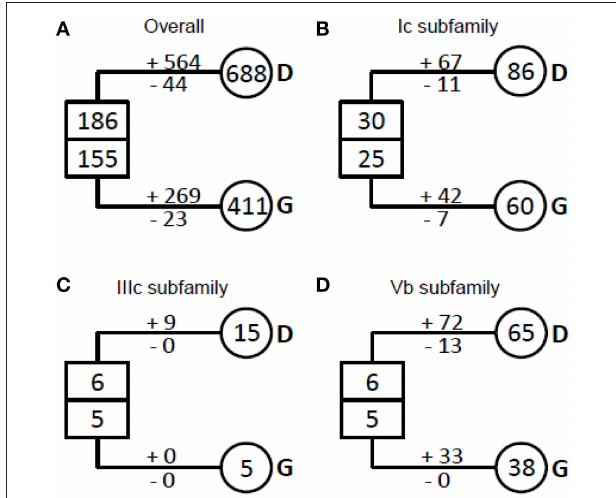
FIGURE 3 | Evolutionary change of the number of NAC TFs in plants. (A) The overall NAC TFs examined in plants; (B) The Ic subfamily of the NAC TFs examined; (C) The IIIc subfamily of the NAC TFs examined; (D) The IVb subfamily of the NAC TFs examined. The numbers in circles and rectangles represent the numbers of genes in extant and ancestral species, respectively. The numbers with plus and minus signs indicate the number of gene gains and losses, respectively, for each branch (D, dicots and G,